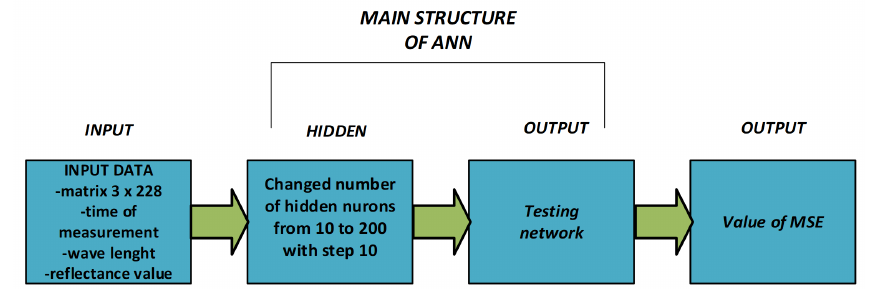
Figure 5. General structure of ANNs.